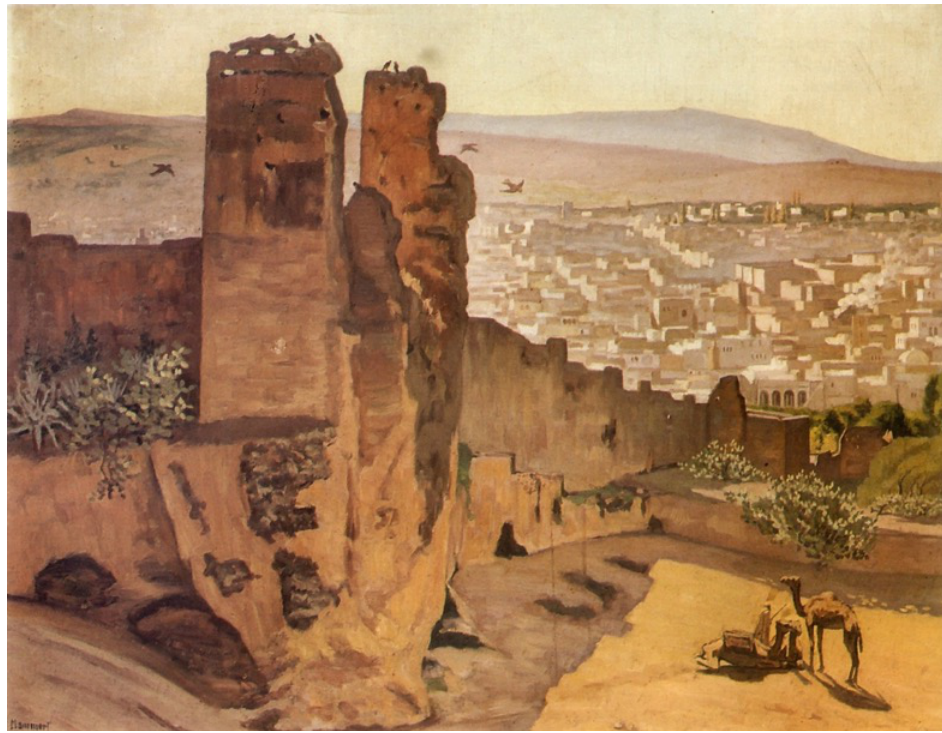
Azouaou Mammeri, Vue de Fez , 1920. Oil on canvas. 70 x 92 centimeters. Musée d’Orsay, Paris, France.  Artepics/age